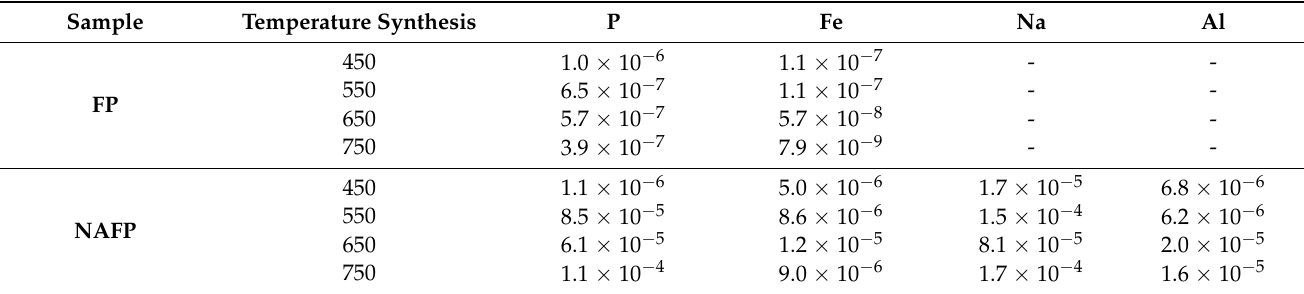
Table 5. The normalized leaching rate of NAFP and FP matrices components according to the PCT standard test.